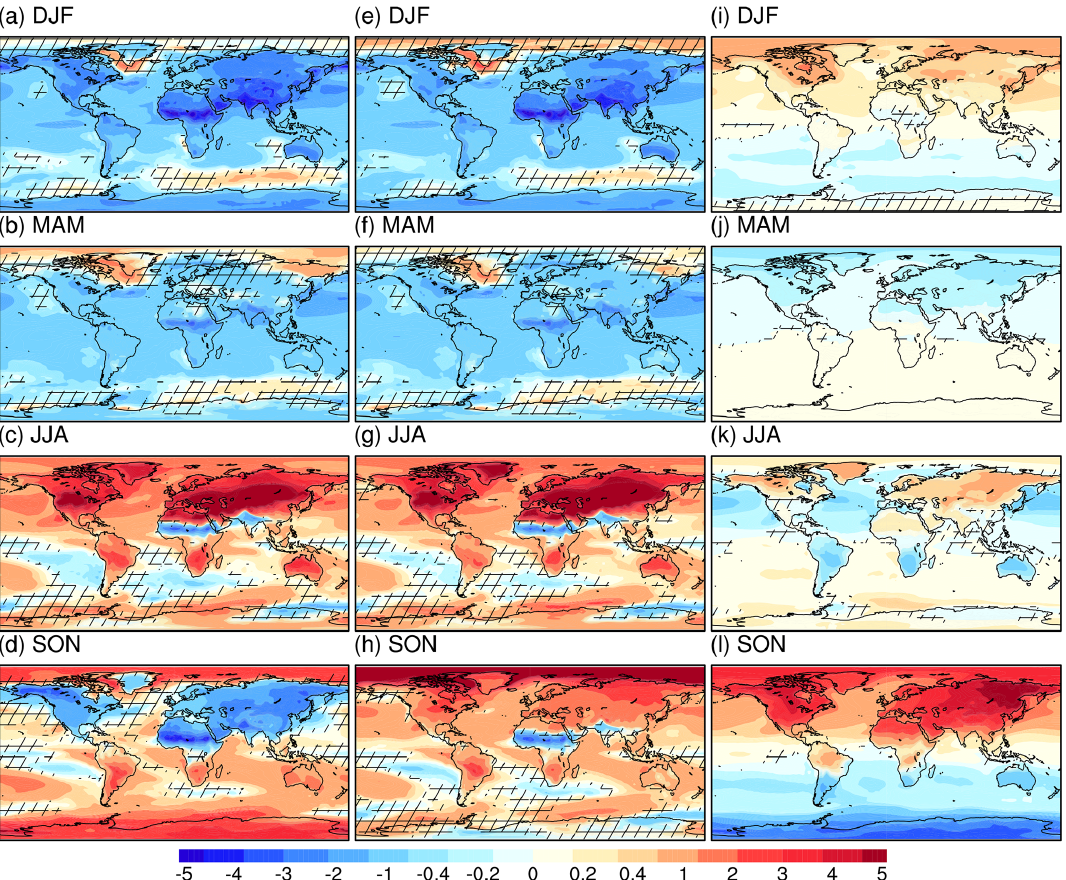
Figure 3. Ensemble surface air temperature for (a–d) LIG minus PI classical means, (e–h) LIG minus PI angular means, and (i–l) anomalies between LIG minus PI angular means and LIG minus PI classical means. The unmarked area indicates that at least seven models show the same sign. Units: